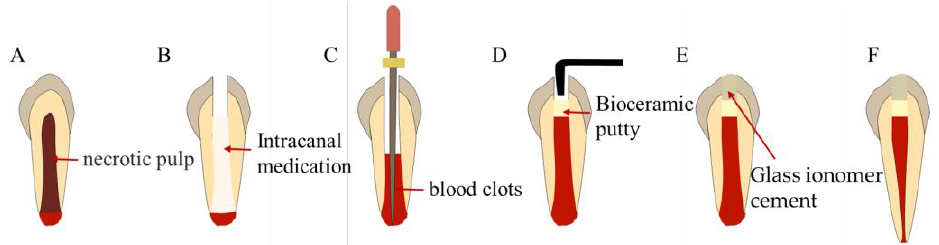
Figure 10. Treatment procedures for revascularization. ( A ) Immature necrotic permanent teeth. ( B ) Root canal disinfection. ( C ) Stimulate blood clot formation. ( D ) Fill with bioceramic putty. ( E ) Coronal seal. ( F ) Root development.